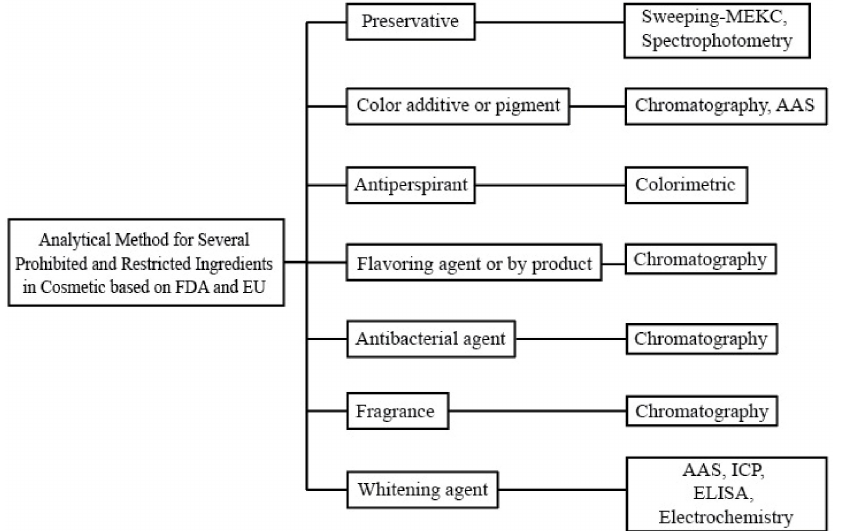
Figure 1. Analytical techniques used for the detection of prohibited and restricted ingredients in cosmetics based on FDA and EU